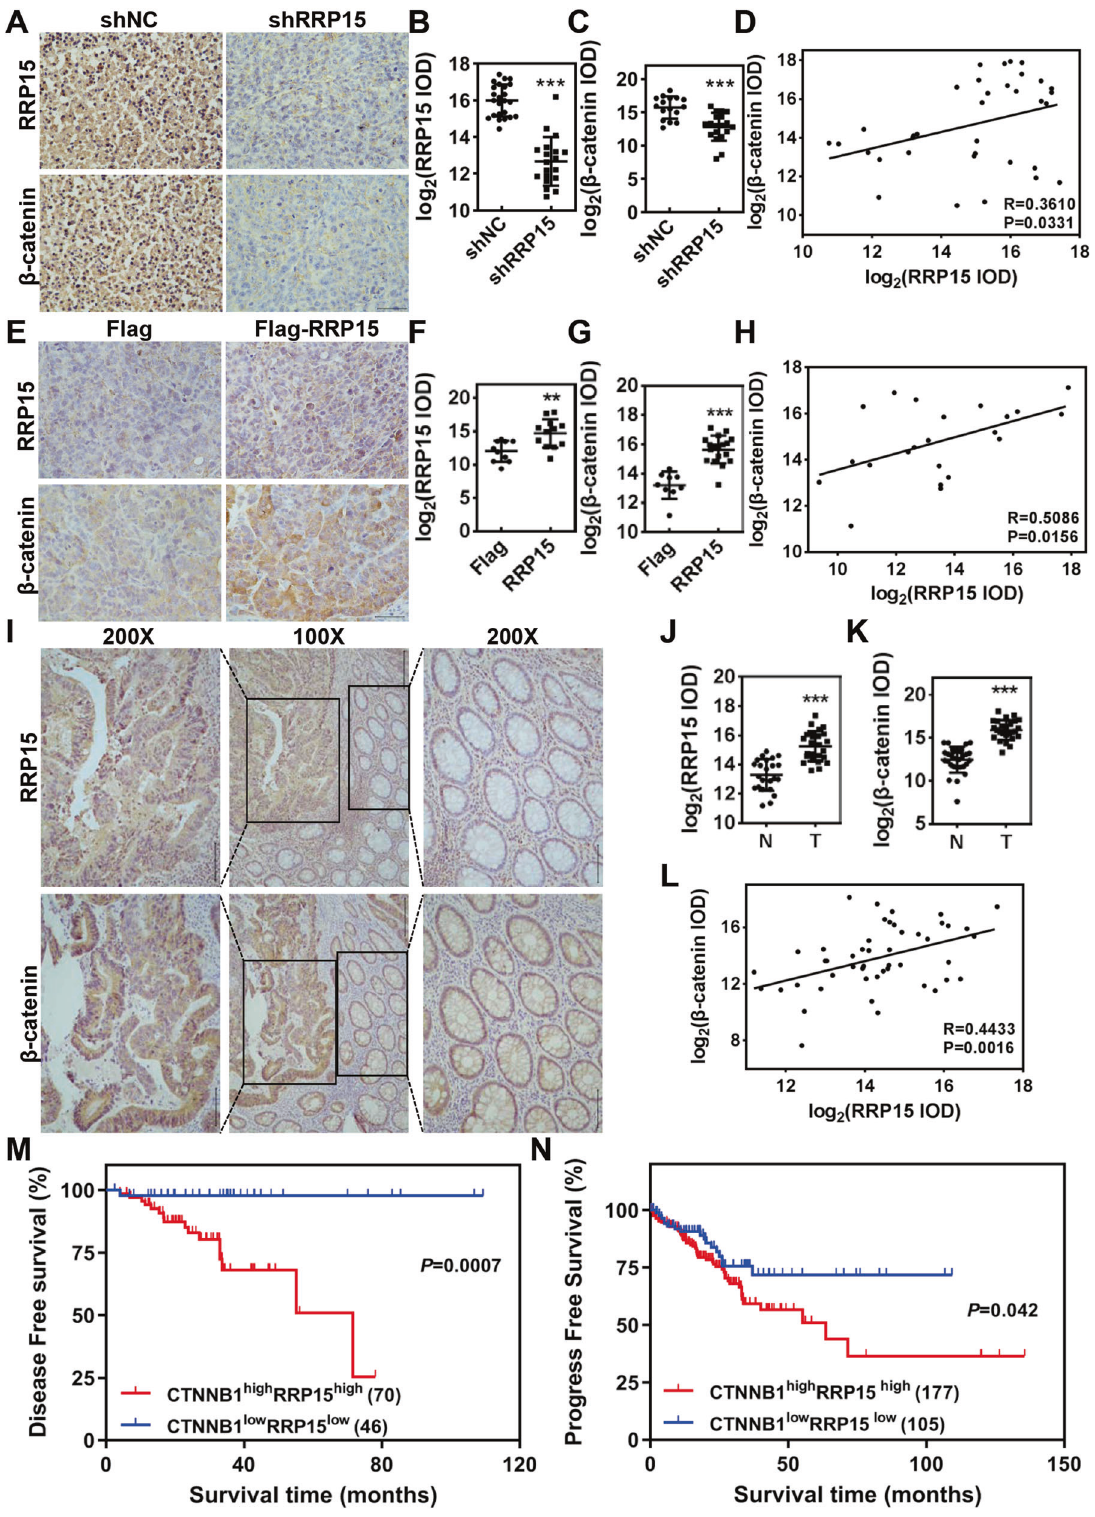
Fig. 6 RRP15 and β -catenin are positively correlated in tissues and associated with prognosis of CRC patients. A – H Representative immunohistochemical staining images of RRP15 and β -catenin in tissues from indicated subcutaneous xenograft tumors. The immunostaining intensities of RRP15 and β -catenin were quanti fi ed by IOD and the relationship between β -catenin and RRP15 were analyzed. Three more random areas of each sample were measured. I – L Representative immunohistochemical staining images of RRP15 and β -catenin in tissues from CRC patients. The immunostaining intensities of RRP15 and β -catenin were quanti fi ed by IOD and the relationship between β -catenin and RRP15 were analyzed. Three more random cancerous or non-cancerous areas of each sample were measured. DFS ( M ) and PFS ( N ) of CRC patients from TCGA cohort with CTNNB1 high / RRP15 high or CTNNB1 low / RRP15 low were analyzed by Kaplan – Meier survival analysis. Scale bar: 100 μ m. data are shown as mean ± standard deviations. ** P < 0.01 and *** P < 0.001. Cell Death and Disease (2023)